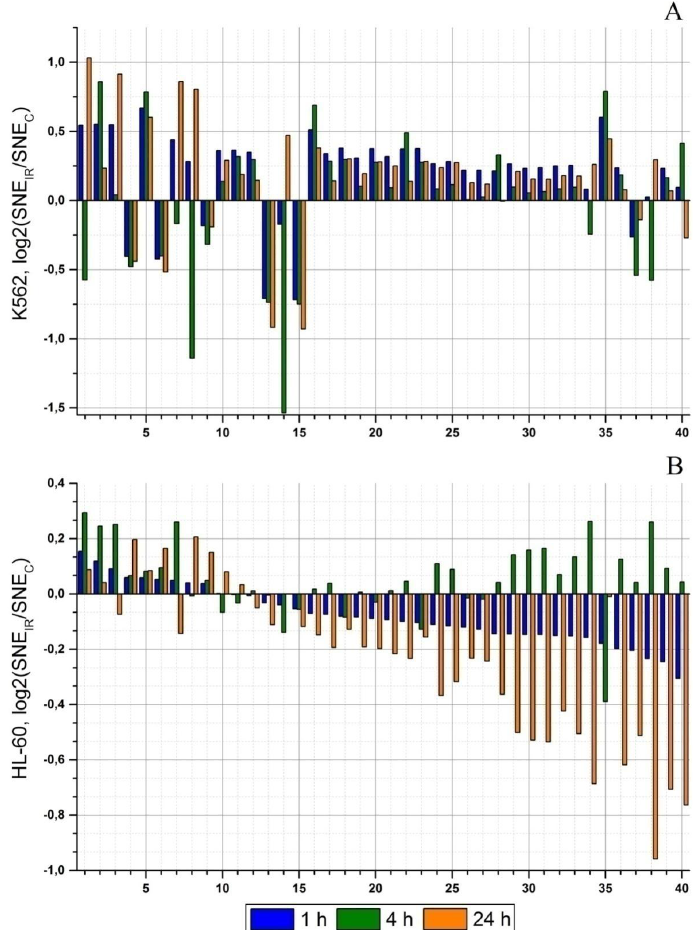
Figure 3. Dynamics of changes of microRNA effects on signaling pathways 1, 4, and 24 h after irradiation at the dose of 4 Gy. Only signaling pathways with statistically significant differences of log2(SNE IR /SNE C ) values between the K562 and HL-60 cell lines are included at any experimental point ( p < 0.01). ( A ) The K562 cell line. ( B ) The HL-60 cell line. Signaling pathway code: 1—Neuroactive ligand-receptor interaction (hsa04080); 2—Longevity regulating pathway—multiple species (hsa04213); 3—Ubiquitin mediated proteolysis (hsa04120); 4—Pertussis (hsa05133); 5—NF-kappa B signaling pathway (hsa04064); 6—Regulation of actin cytoskeleton (hsa04810); 7—Fanconi anemia pathway (hsa03460); 8—Amoebiasis (hsa05146); 9—PI3K-Akt signaling pathway (hsa04151); 10— Epstein-Barr virus infection (hsa05169); 11—AMPK signaling pathway (hsa04152); 12—Salmonella infection (hsa05132); 13—Shigellosis (hsa05131); 14—Type II diabetes mellitus (hsa04930); 15— Bacterial invasion of the epithelial cells (hsa05100); 16—Leukocyte transendothelial migration (hsa04670); 17—Bladder cancer (hsa05219); 18—Toll-like receptor signaling pathway (hsa04620); 19—